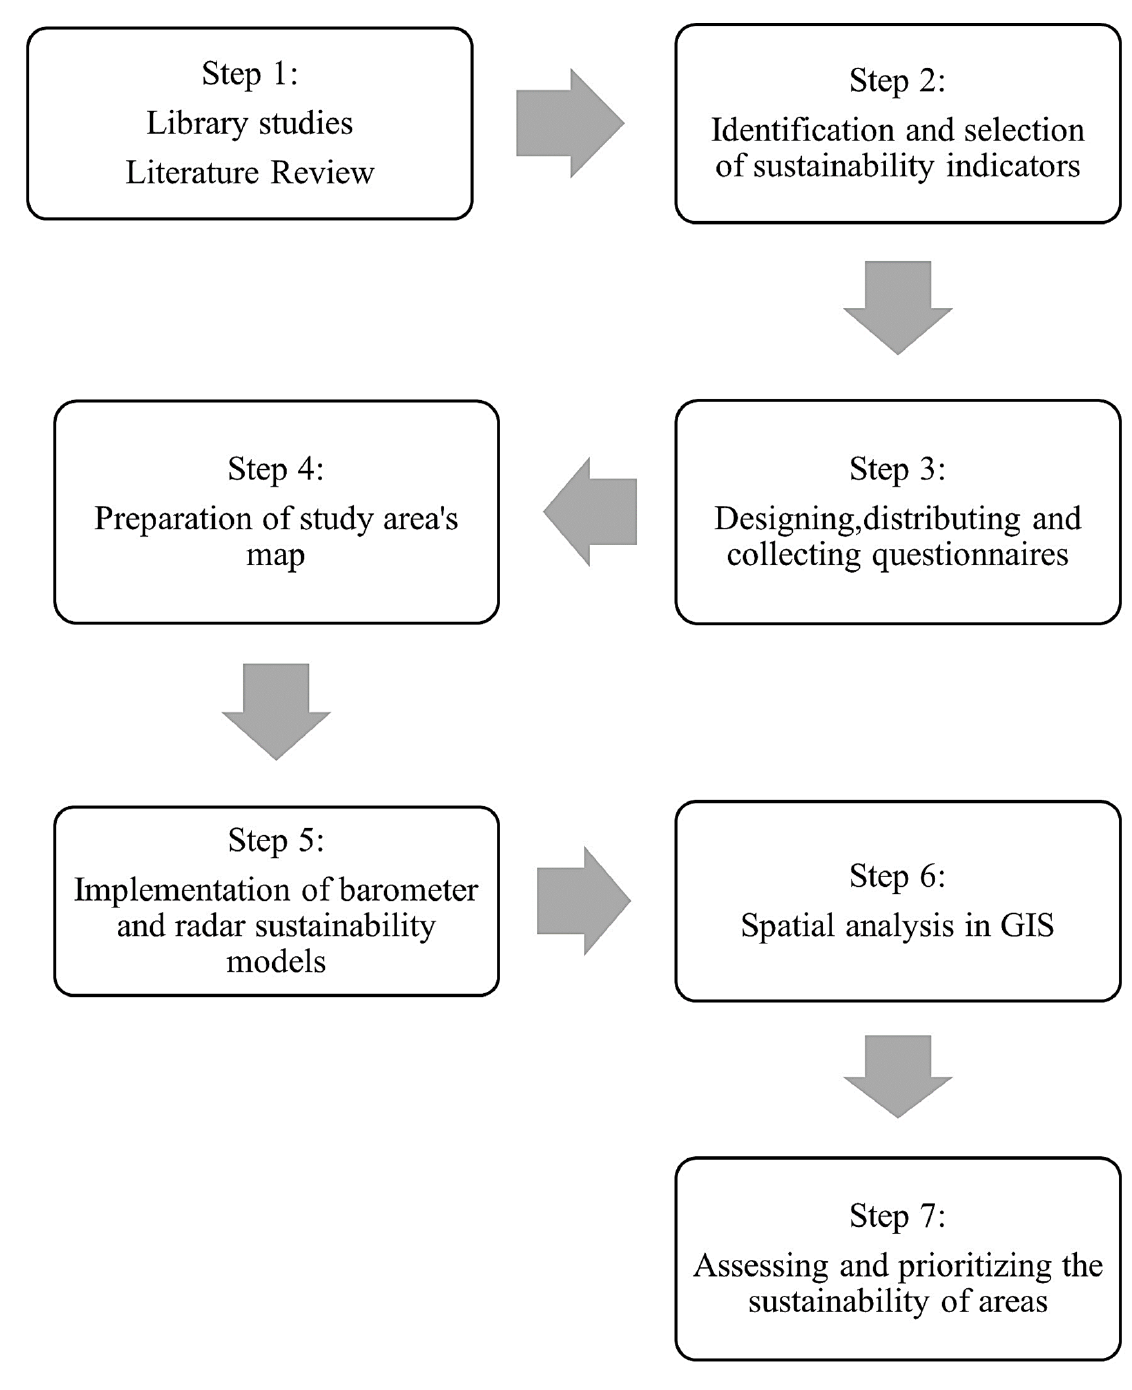
Figure 2. Flowchart of the research process. Table 2. Final indicators used to assess the urban s ustainability in 9 regions of District 4: Ecosystem